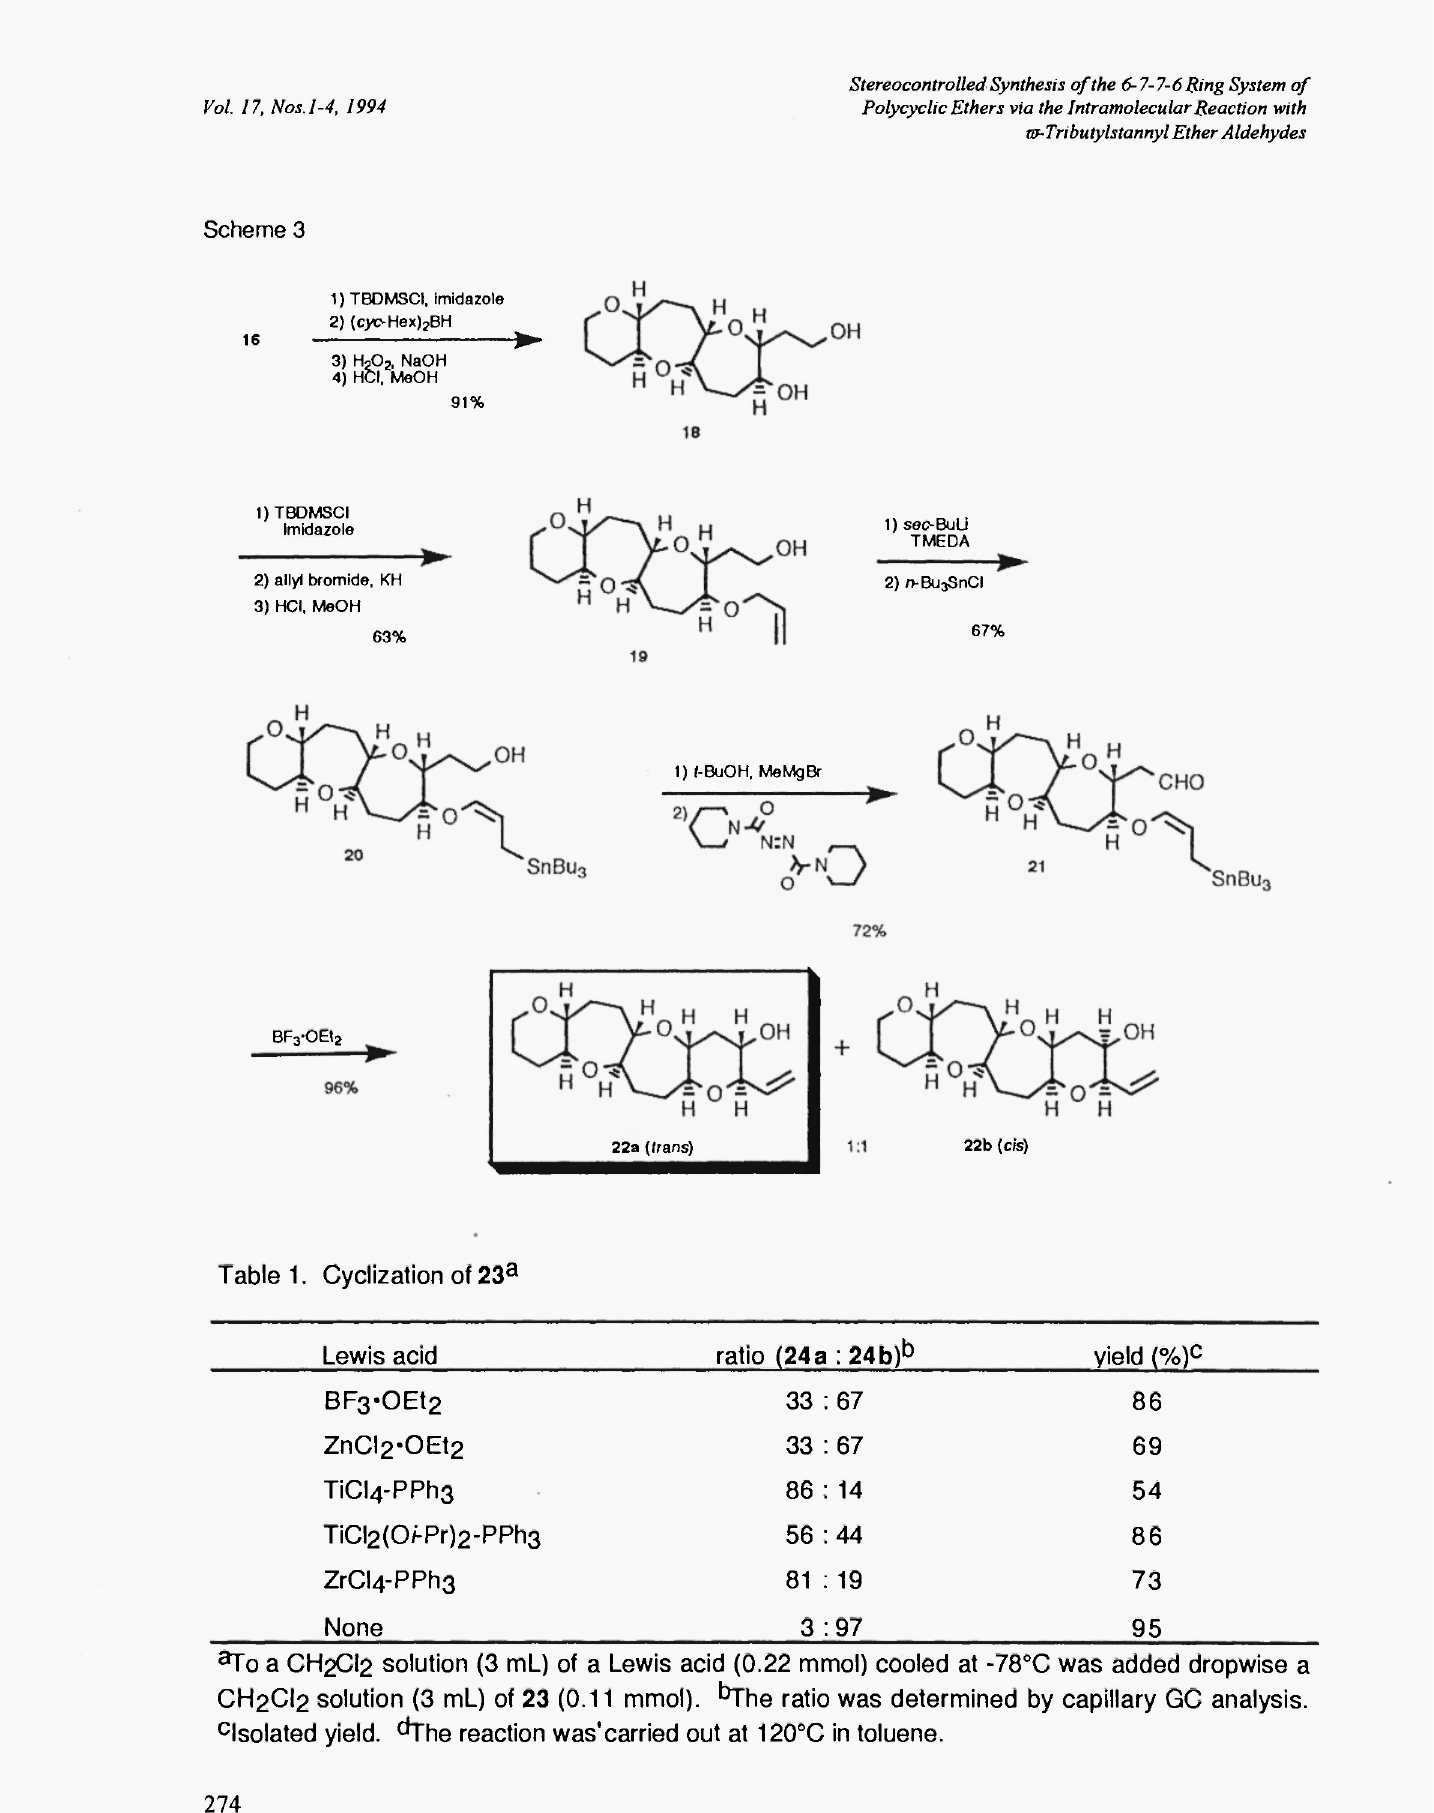
Table 1. Cyclization of 23 a